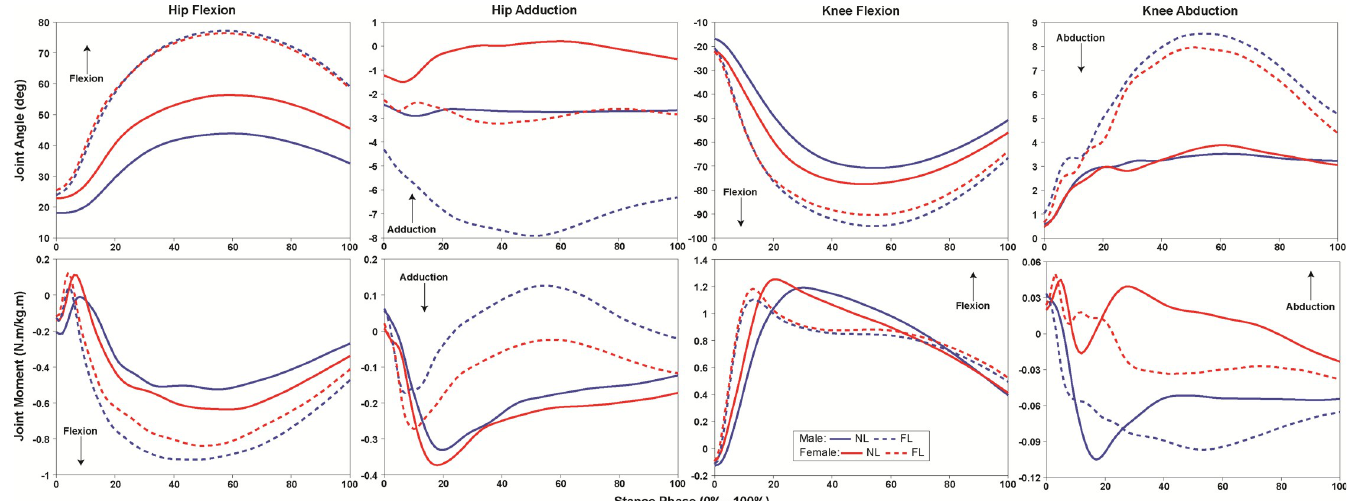
Fig 2. Landing phase (0–100%) hip and knee joint range of motion (ROM) and moments exhibited by males (blue) and females (red) during normal (NL, solid line) and flexed (FL, dashed line) landing.